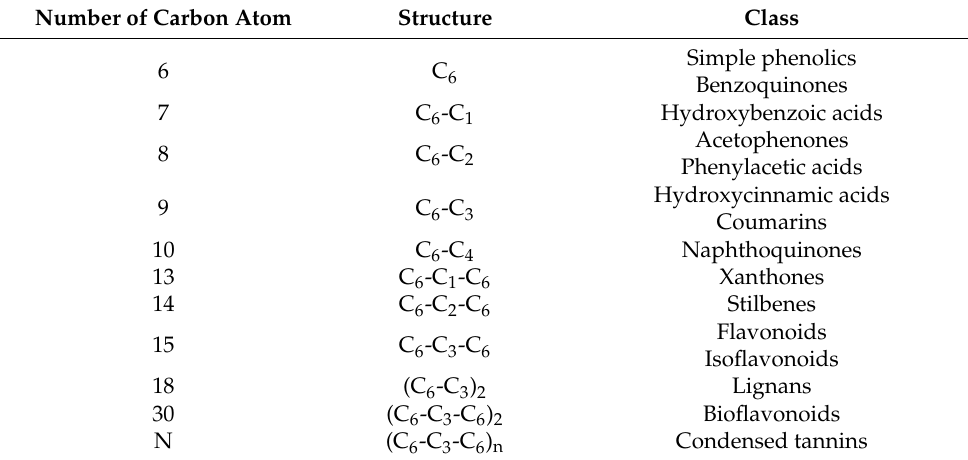
Table 2. Classes of phenolic compounds in the plant kingdom.